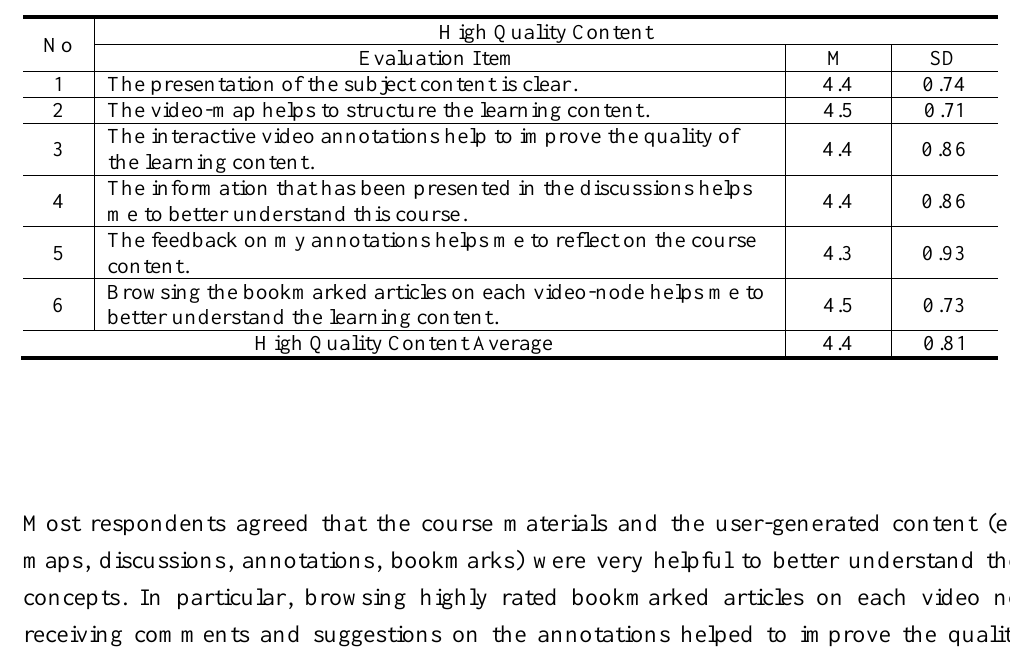
Descriptive Results of High Quality Content